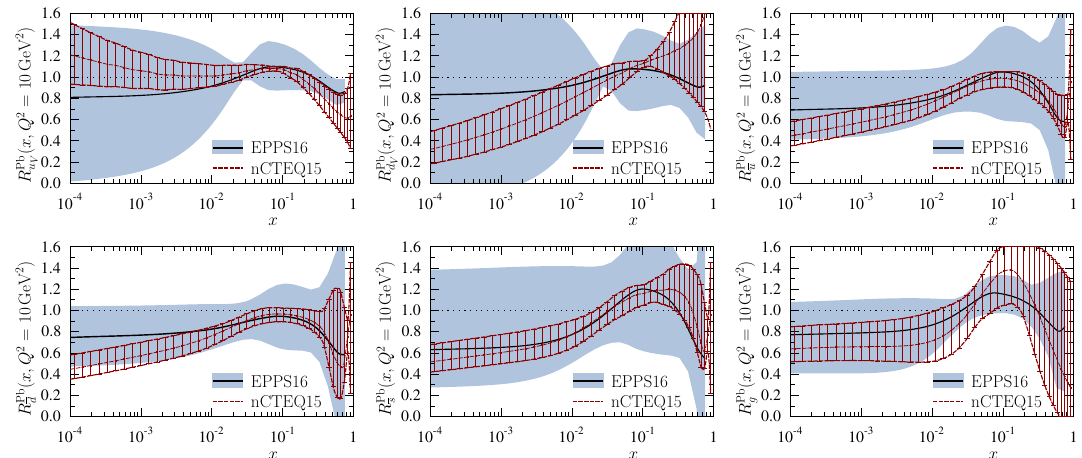
Fig. 24 The values of χ 2 / N data from the baseline fit ( red bars ) and EPPS16 ( green bars ) for data in Table 1